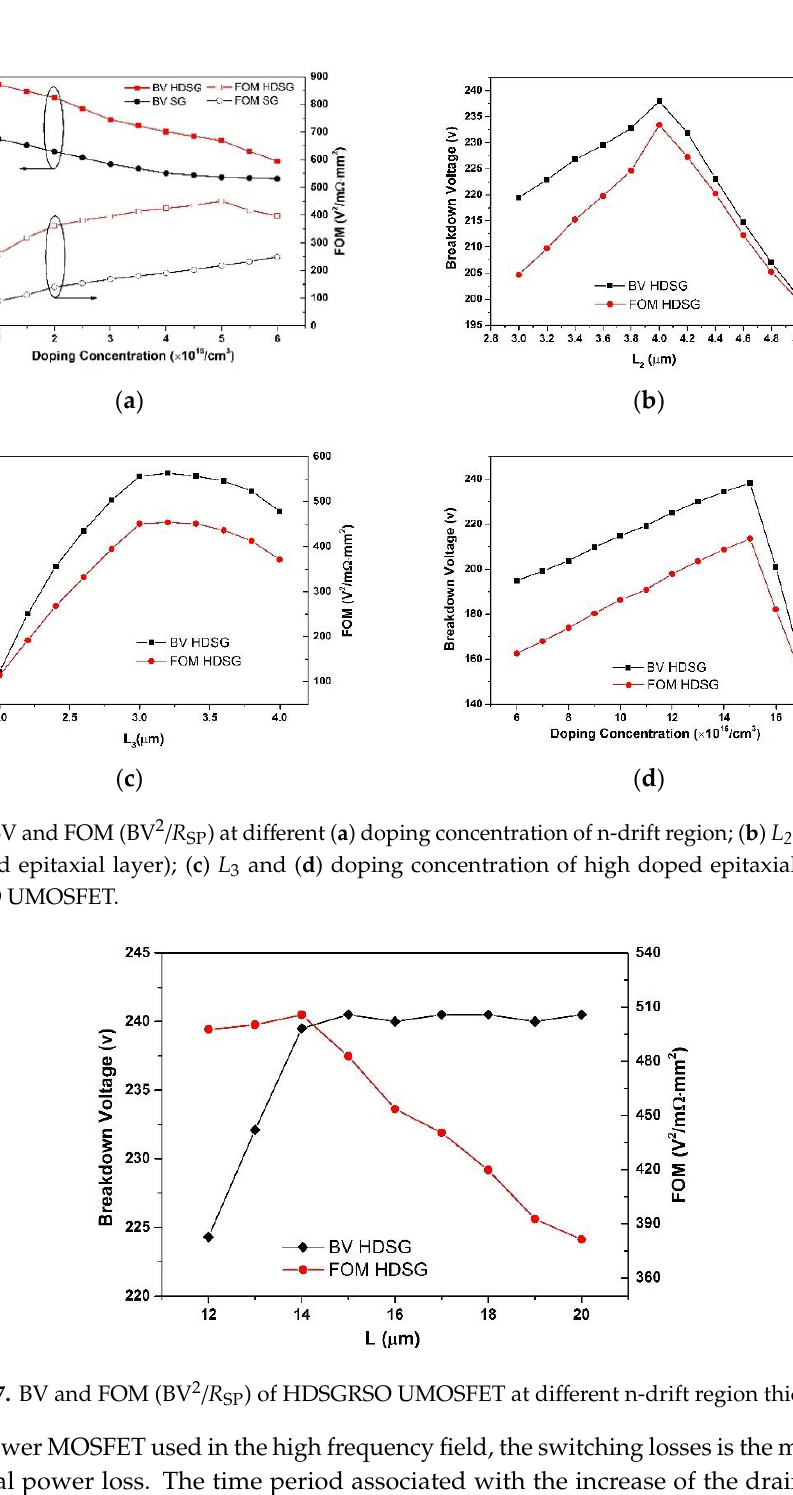
( b ) Figure 8. The Crss and Ciss (BV 2 / R SP ) at different drain voltage ( a ) and ( b ) comparison of gate charge and R SP  Q gd for HDSGRSO and SGRSO UMOSFETs.